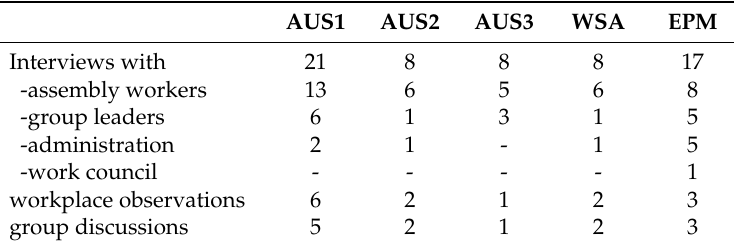
Table 2. Overview of empirical basis.